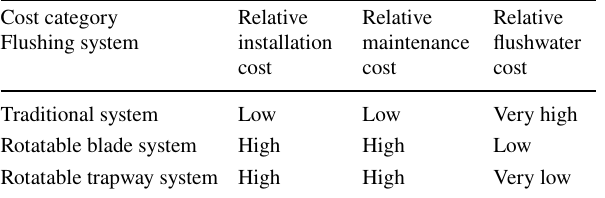
Table 3 Relative costs of traditional, rotatable blade mechanism and rotatable trapway